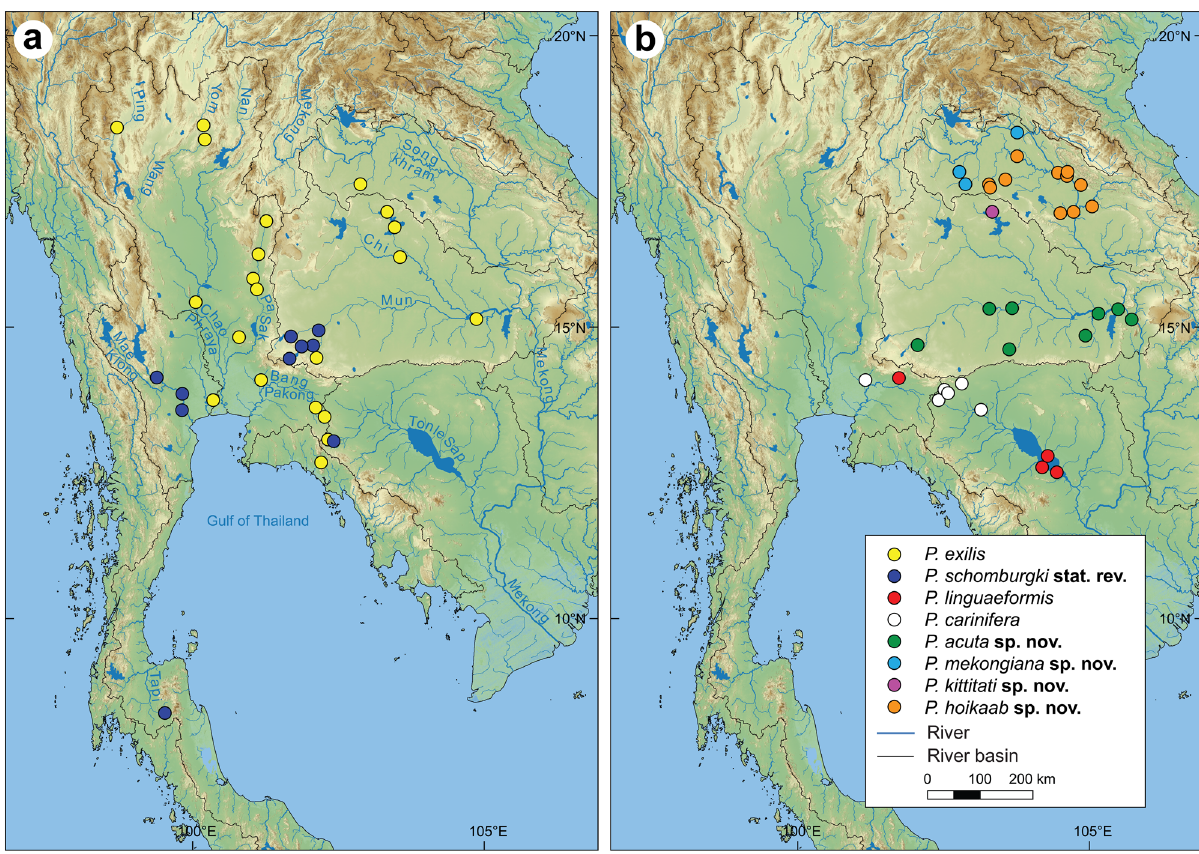
Figure 4. ( a,b ) Map of mainland Southeast Asia showing the distribution of Pilsbryoconcha species and the main river systems. Maps were developed using QGIS v3.24.3 by compiling topographic base map of freshwater river basins from the Freshwater Ecoregions of the World (https:// www. feow. org), river and lake topology from the HydroSHEDS database (https:// www. hydro sheds. org), and map raster data from the NASA EARTHDATA (https:// www. earth data. nasa. gov/).